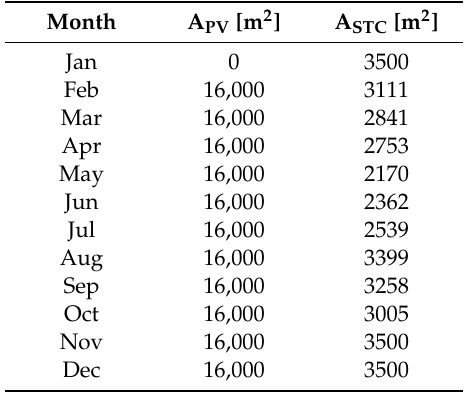
Table 4. PV and STC in twelve monthly optimizations.